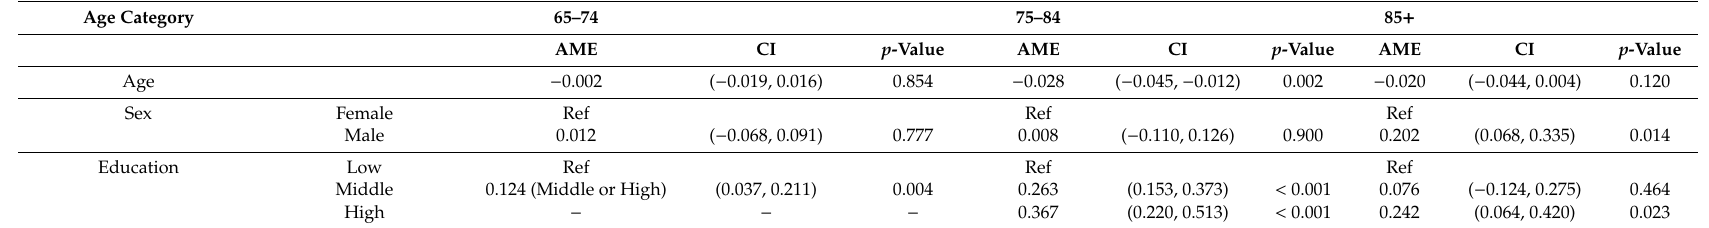
Table 6. Multivariate binary logistic regression analyses in three age categories. Internet use as the dependent variable. Average marginal e ff ects (AME) with 95% confidence intervals (CI) for the factors and p -values for the beta-coe ffi